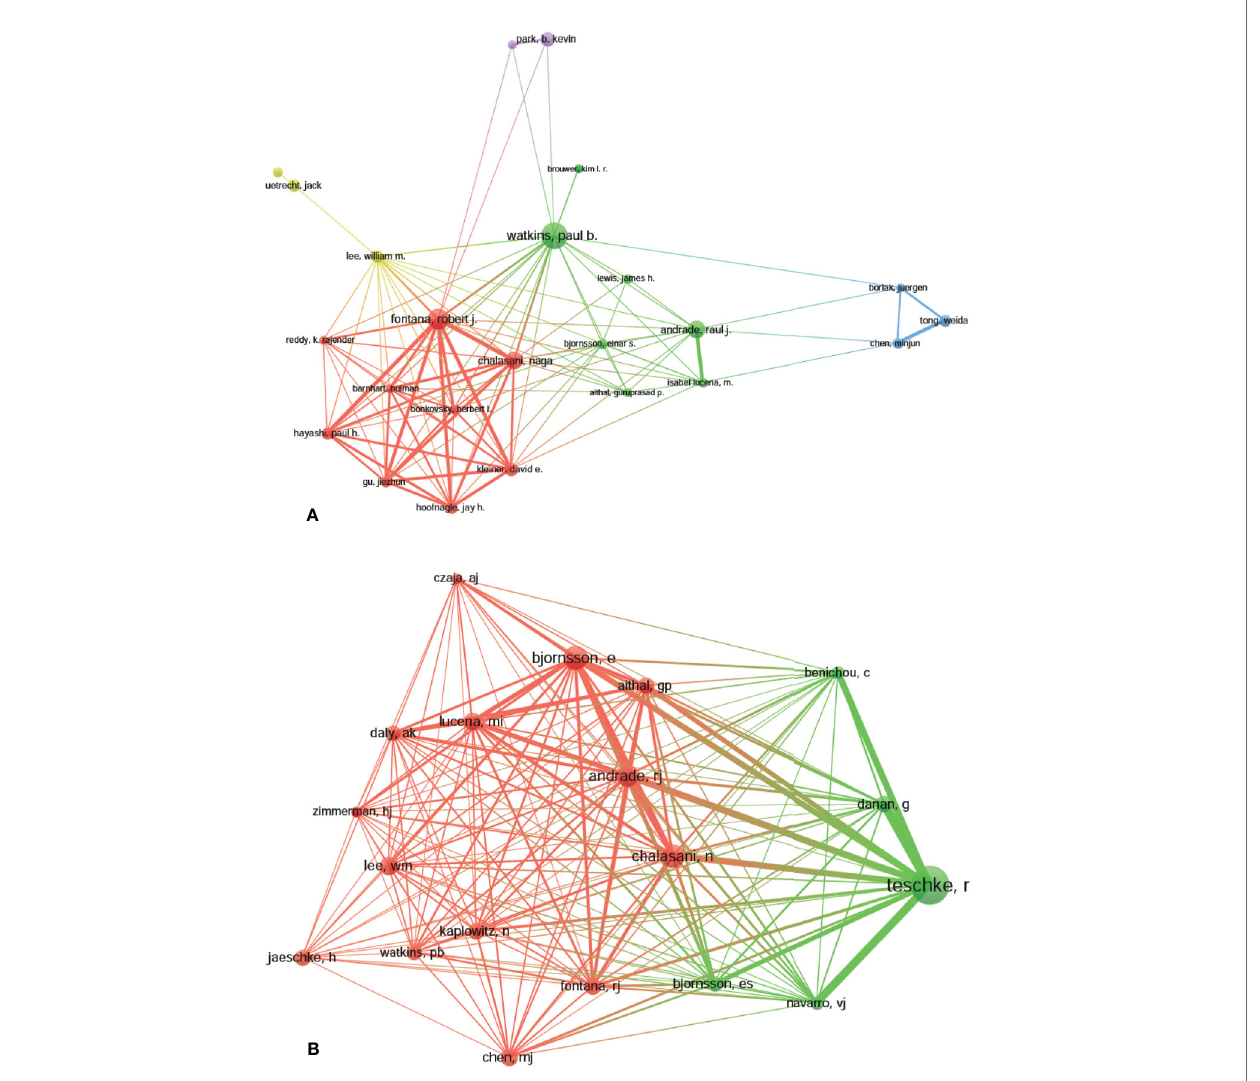
FIGURE 6 | The network map of authors ( A , T = 17) and co-cited authors ( B , T = 230) related to drug-induced liver injury (DILI) research.